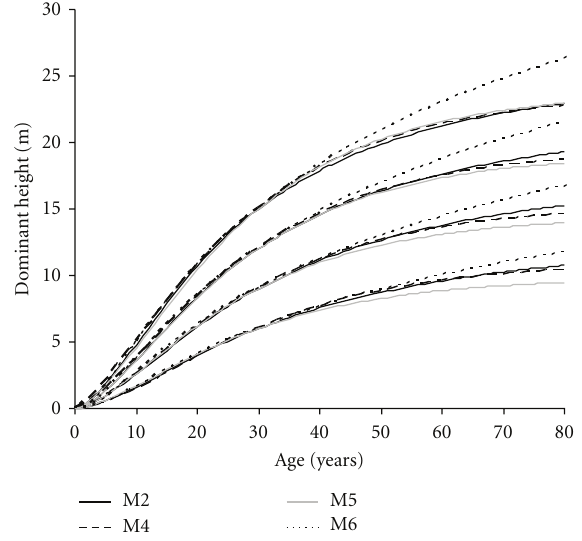
Figure 3: Height growth curves for site index values of 6, 9, 12 and 15m at reference age of 30 years for the dynamic models M2, M4– M6, which was developed considering two site-specific parameters in their corresponding base